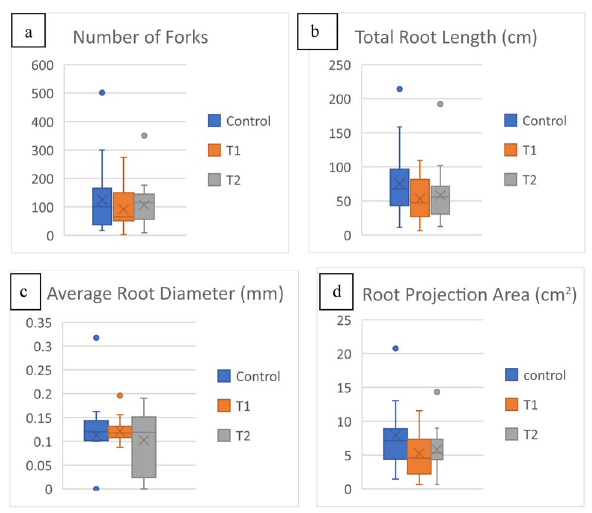
Figure 4. Box and Whisker charts showing variation in root morph traits measured for control, (T1) PEG 15% PEG and T2 (20%) treatments ( a ) forks, ( b ) total root length (TRL)-cm, ( c ) average root diameter (ARD)-mm, ( d ) root projection area (RPA)-cm 2